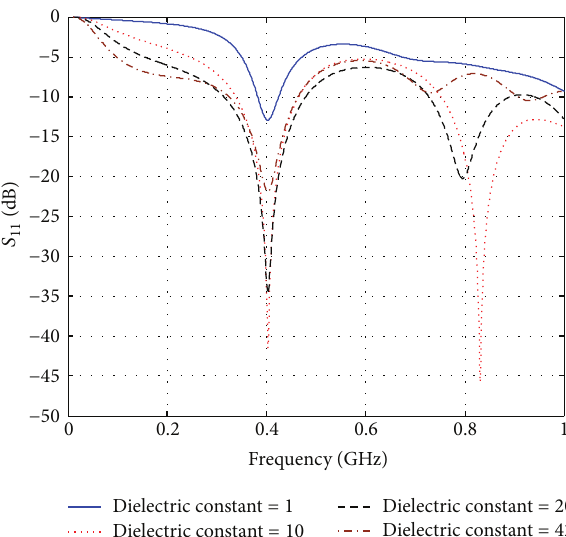
Figure 6: Antenna efficiency versus dielectric constant ( 𝜀 𝑟1 ) at 403 MHz. Figure 7: Return loss of antenna with different dielectric constants (1, 10, 20, and 42) at 403 MHz.